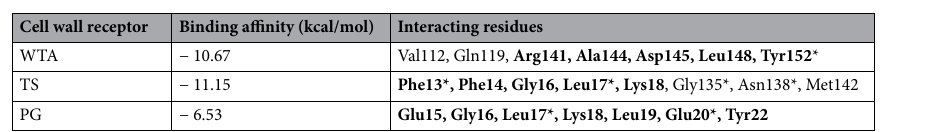
Table 1. Summary of molecular docking analysis of CL1-C600M2-lysin with selected bacterial cell surface receptors as represented in Ligplot interaction map in Fig. 4d–f. The binding affinity of all the protein–ligand partners were for the 1st ligand conformation as predicted by MTiAutoDock. Sequential amino acid residues are in bold. *Residues forming hydrogen bond.